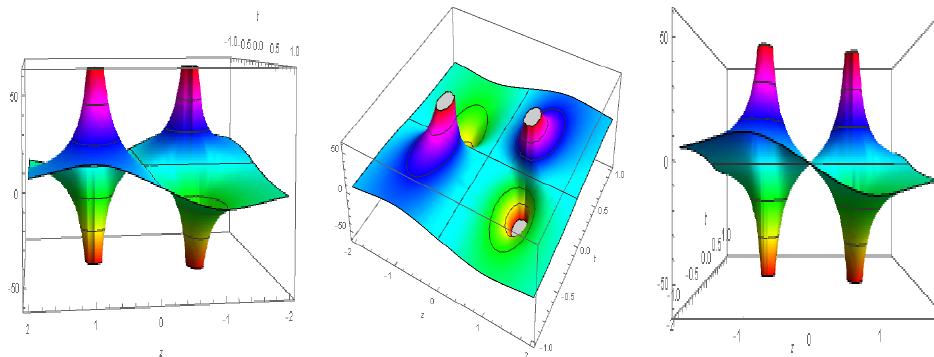
Figure 15. The SRW profiles of the solution ∆ 8 in Equation (30) are made for values of (cid:101) = 0.5, b = 1, c = 3, γ = 0.1, ν = 10, µ = 2 and κ = 2. Three-dimensional graphs at (i) δ = − 5, (ii) δ = 10 and (iii) δ = 20.